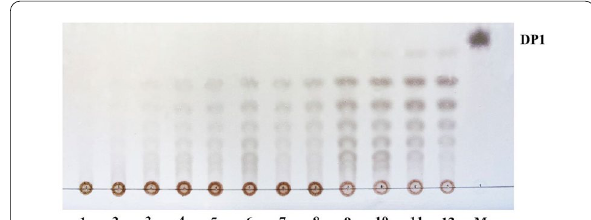
Fig. 6 TLC analysis of the ErPelPL1 hydrolyzed products for different times. Lanes 1–12, the samples taken by 5 min, 10 min, 15 min, 30 min, 1 h, 2 h, 4 h, 6 h, 12 h, 24 h, 48 h and 72 h. Lane M, the